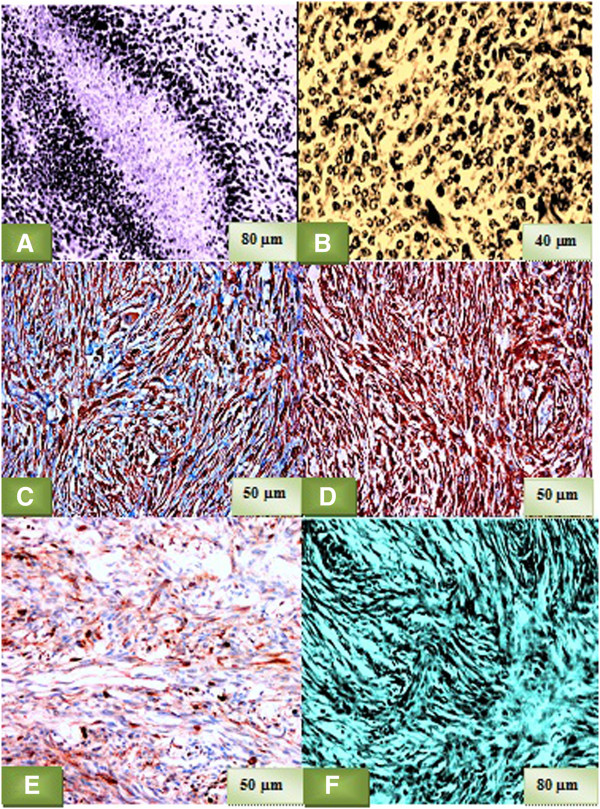
A: Necrotic focus is accompanied by nuclear pseudopalisading in MPNST, 2B: Neoplastic cells with cytoplasm and round nuclei are arranged in a cordlike pattern, 2C: The neoplastic cells show diffuse expression of S-100. IHC, 2D: The neoplastic cells show strong expression of vimentin. IHC 2E: A number of neoplastic cells show a marked cytoplasmic and nuclear immunoreaction for S-100 protein 2F: Fusiform or spindle-shaped neoplasmic cells are arranged in interdacing fascicles.